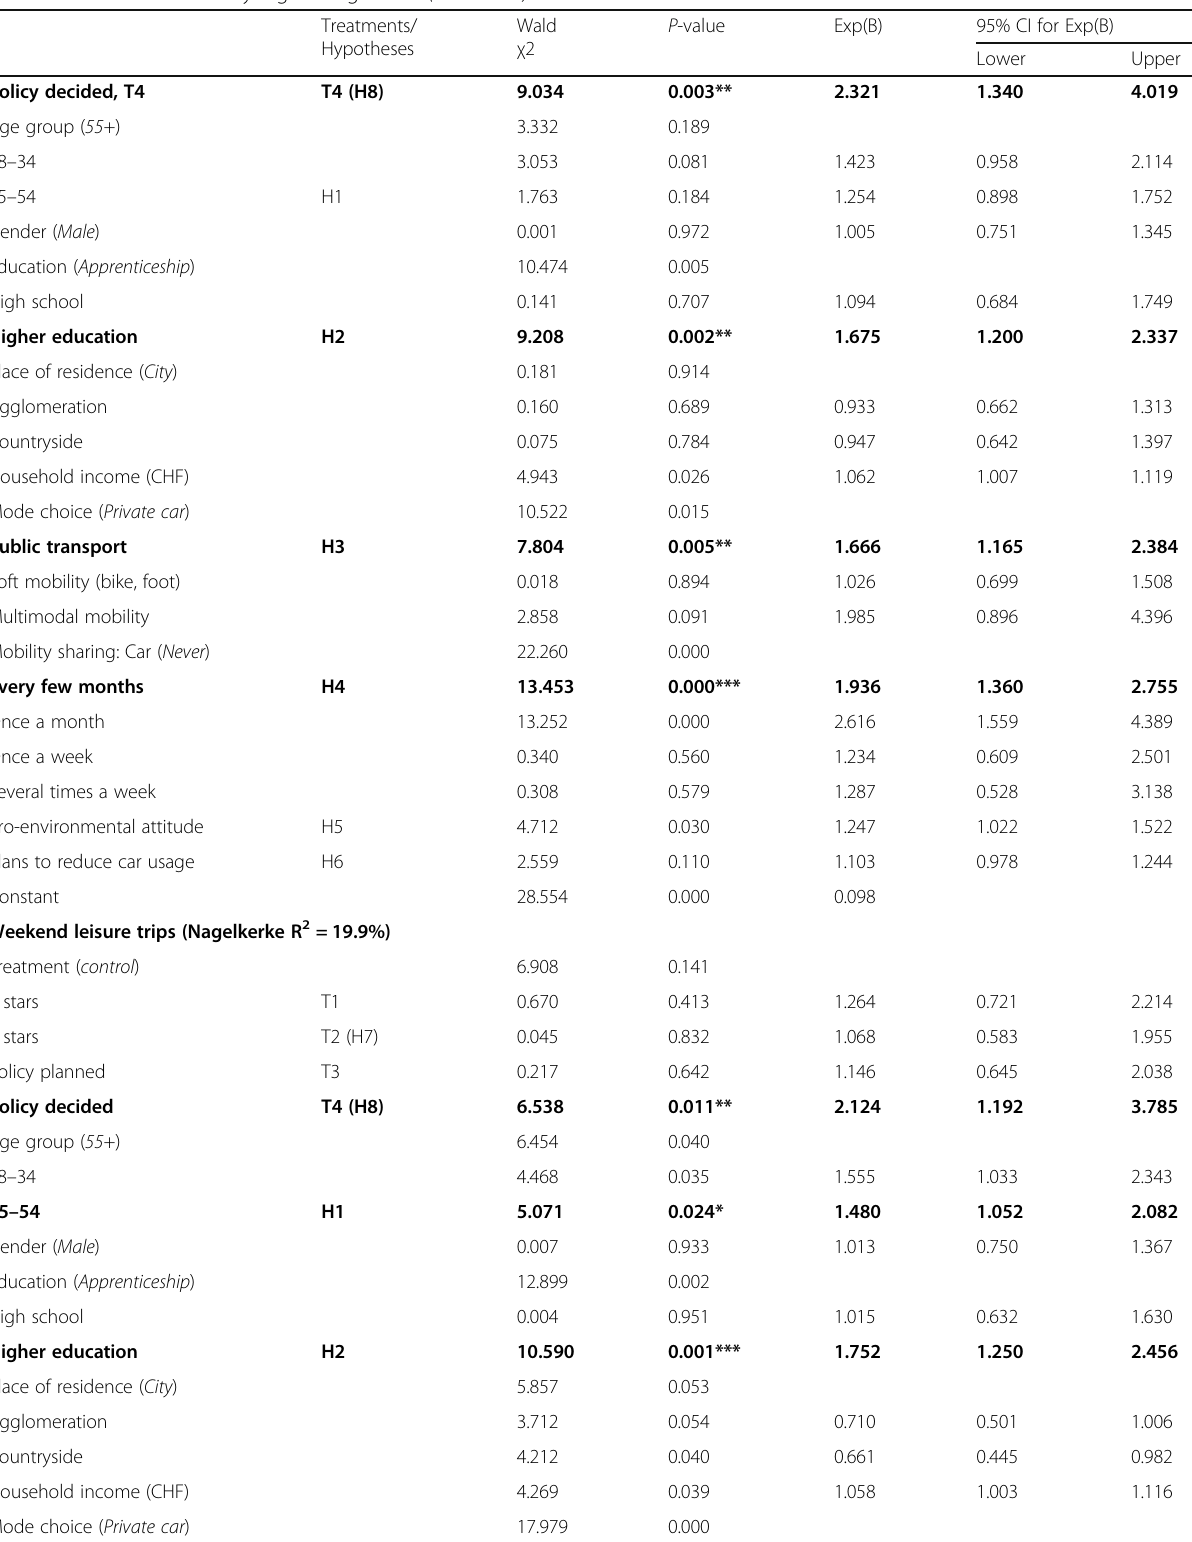
Table 4 Results of the binary logistic regression